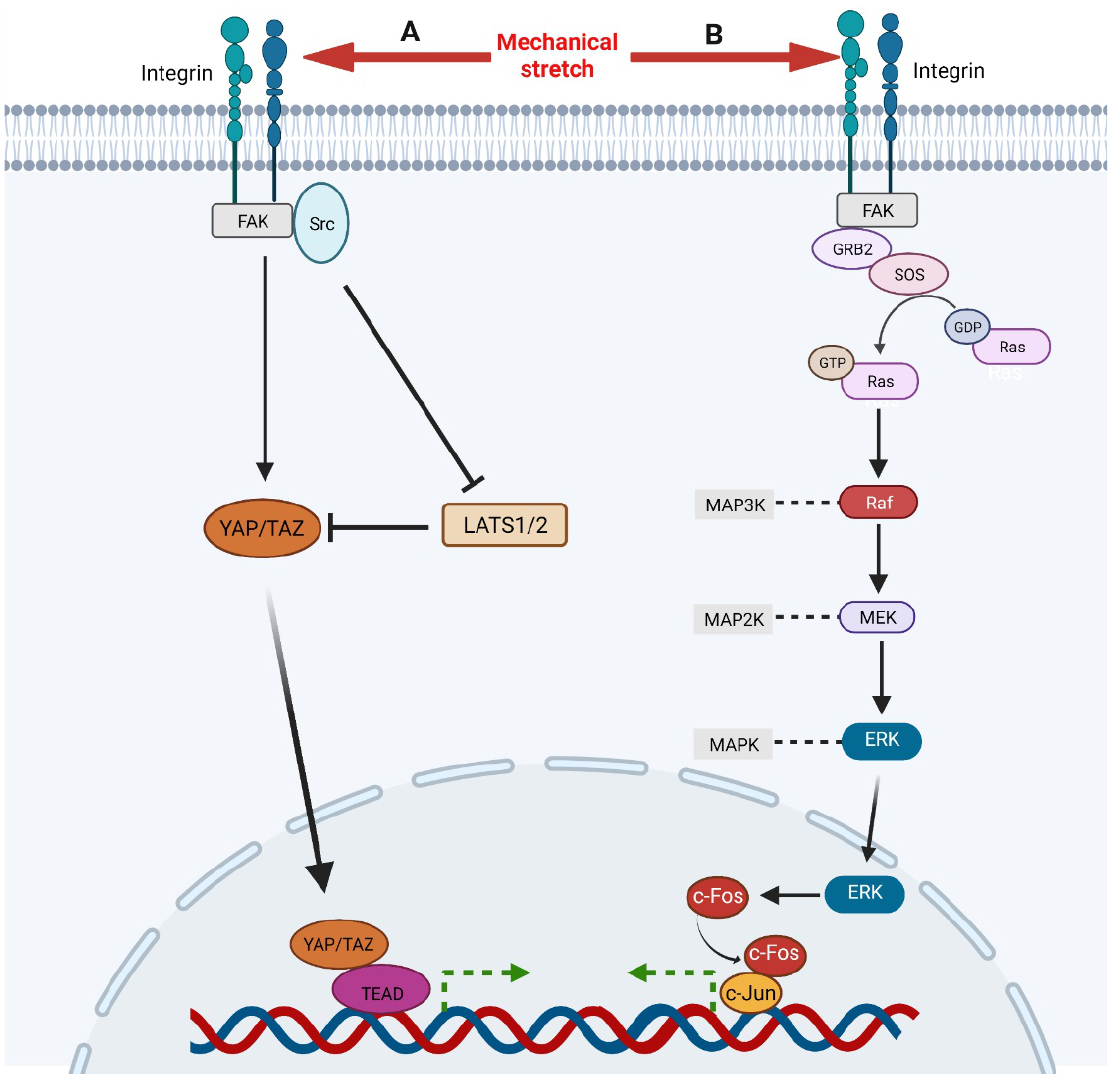
Figure 1. A, Mechanical stimulation, integrin-recruited FAK, and Src activate YAP/TAZ directly and facilitate its nuclear translocation. Meanwhile, FAK and Src can also inhibit LATS1/2, an inhibitor of YAP/TAZ, to activate YAP/TAZ signaling. Then, activated YAP/TAZ translocates to nuclear and binds to TEAD to regulate gene expression. B, Mechanical stimulation activates integrin which recruits and activates FAK. Then FAK activates Ras through GRB2 and SOS, initiating Ras-Raf-MEK- ERK cascade. Ultimately, activated ERK translocates to nuclear to up-regulates and activates c-Fos which binds c-Jun to regulate gene